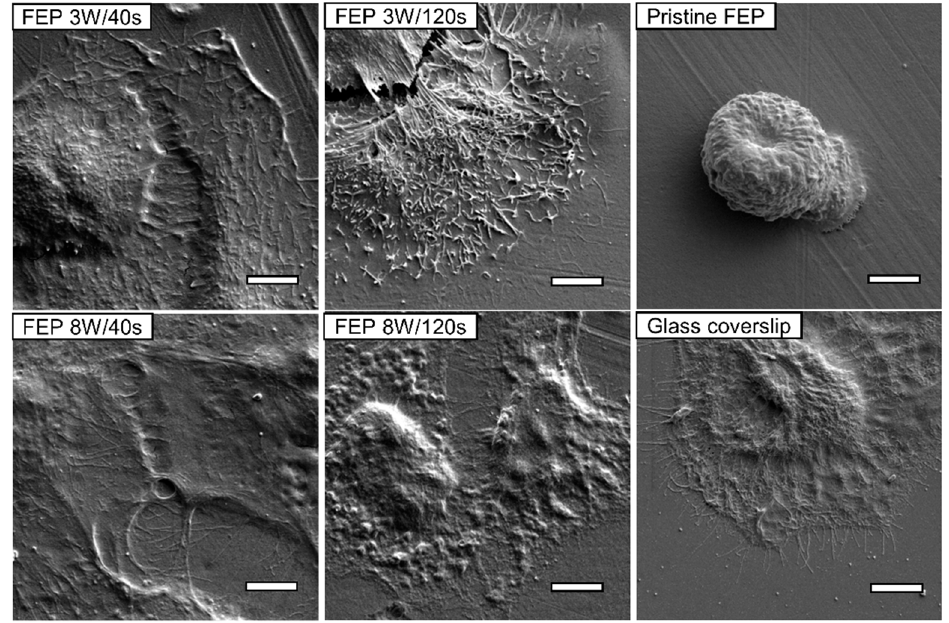
Figure 4. Scanning electron microscopy images of human keratinocytes (HaCaT) 24 h after seeding on plasma treated FEP, pristine FEP and glass coverslip. The power of plasma (3 and 8 W) and treatment durations (40 and 120 s) are given for each image. Scale bar is equal to 5 μ m [80].